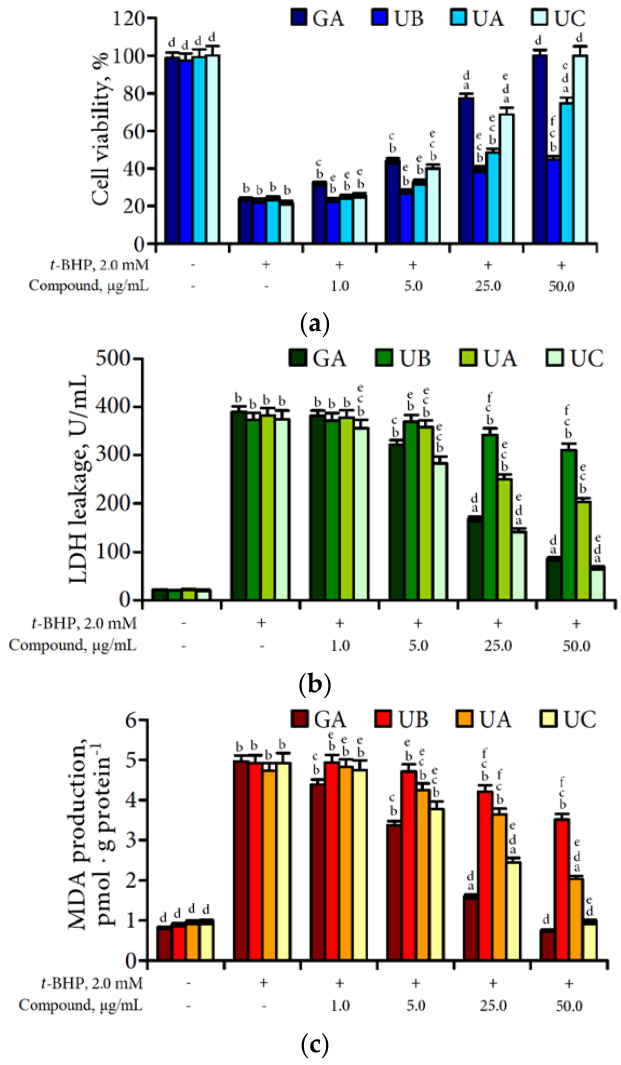
Figure 8. Effect of different concentrations of gallic acid (GA), urolithin A (UA), urolithin B (UB) and urolithin C (UC) on t -BHP-induced cytotoxicity ( a ); LDH leakage ( b ) and MDA production ( c ) in cultured rat hepatocytes. Data presented as a mean ± SD ( n = 4). Letters indicate a significant difference: